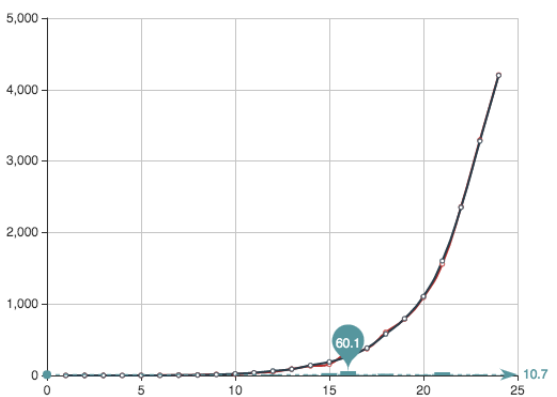
Figure 5. Joint representation of the data in E (red line) and its approximation for the restriction case sum = 1 (black line). The bar graph is the pointwise error with the maximum (red point) and the average (dashed